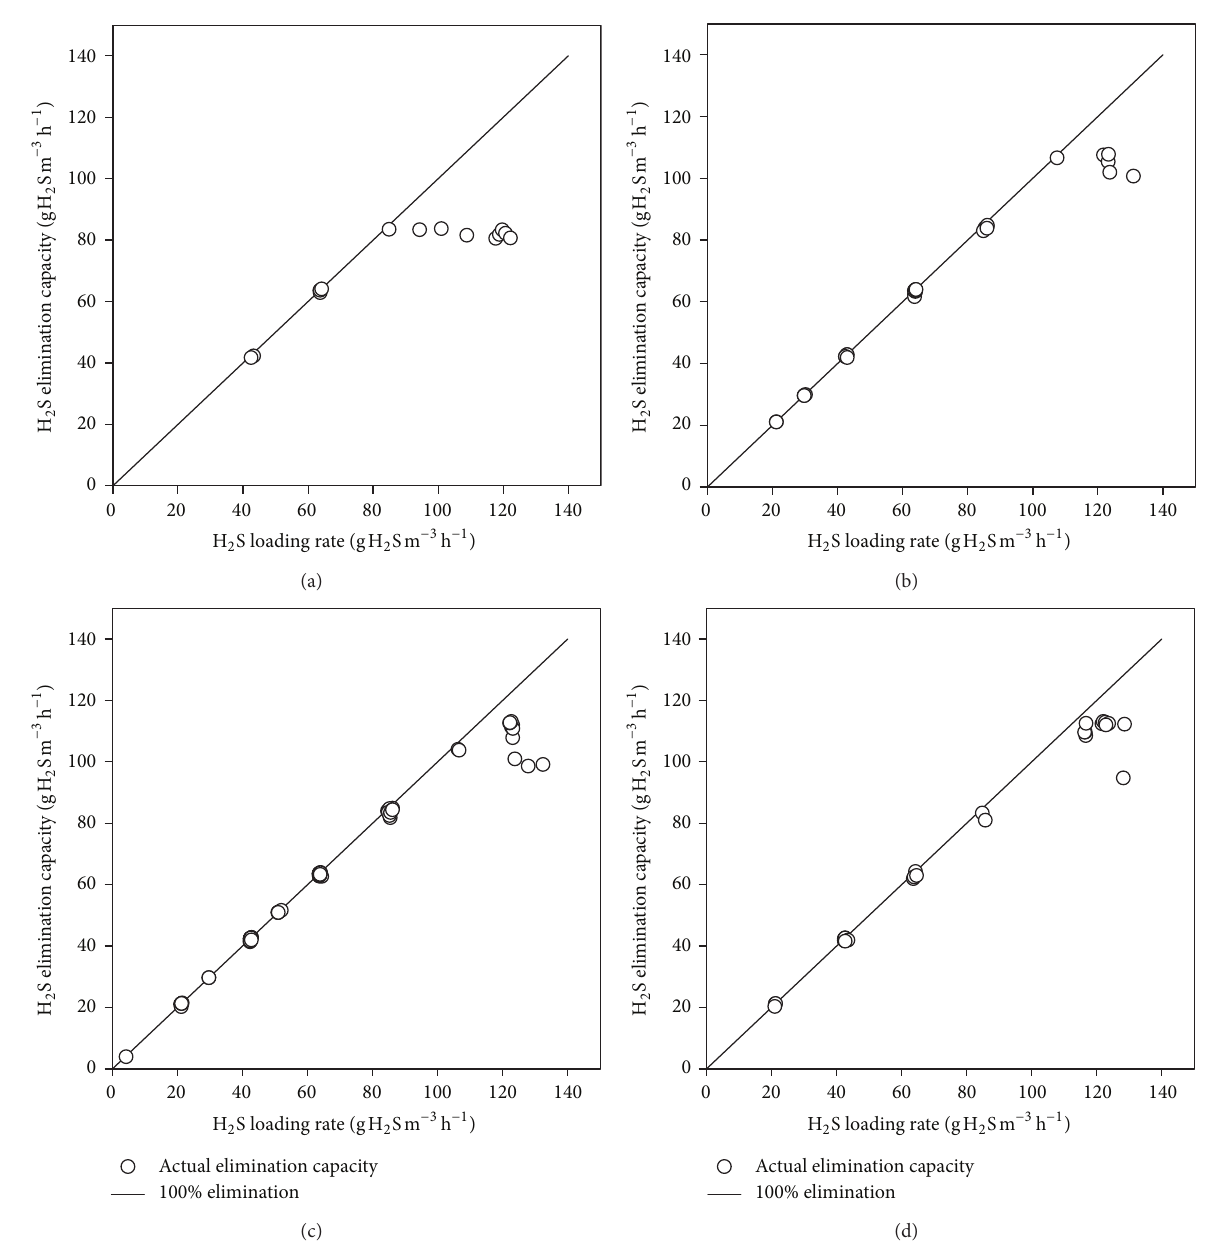
Figure 3: Effect of pH on the maximum elimination capacity of the airlift bioreactor: (a) pH = 6.5–6.9; (b) pH = 7.0–7.4; (c) pH = 7.5–7.9; and (d) pH =